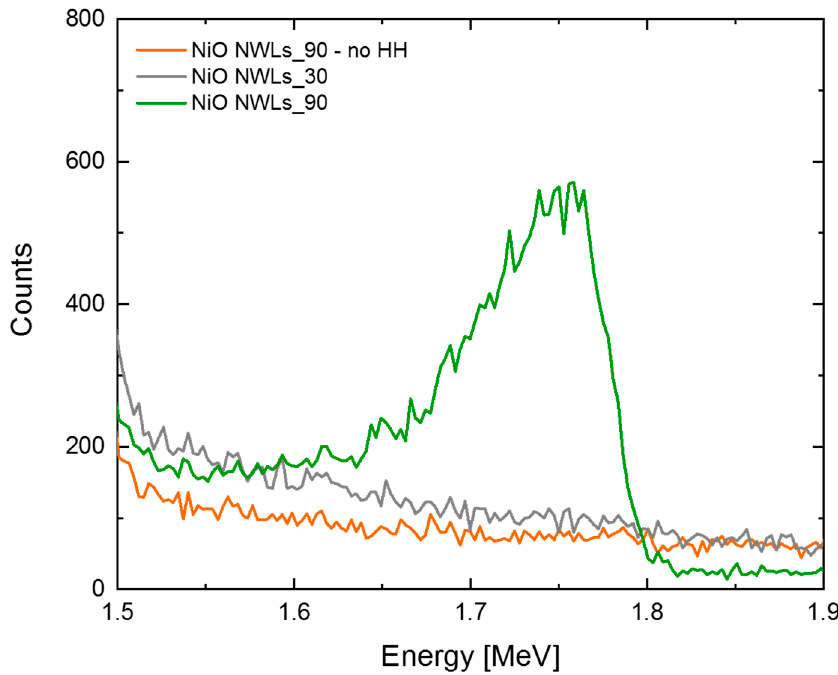
Figure 7. RBS spectra of NiO NWLs immersed for 30 and 90 s in the ELD solution with (NiO NWLs_30, NiO NWLs_90) and without (NiO NWLs_90-no HH) HH pre-bath.